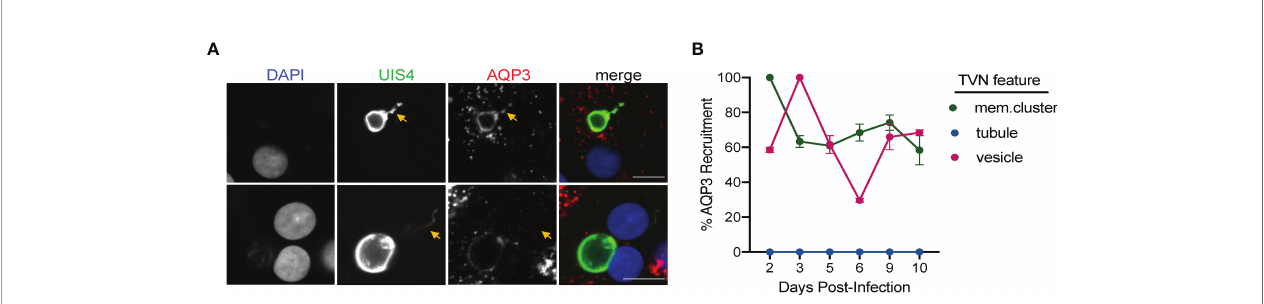
FIGURE 5 | Localization and recruitment of AQP3 to TVN features during P. vivax infection. (A) Representative confocal images of P. vivax EEFs exhibiting TVN features, stained with DAPI (blue), anti- Pv UIS4 (green), and anti- Hs AQP3 (red) at 8 dpi. P. vivax -infected PHH show localization (top) and no localization (bottom) of AQP3 to speci fi c TVN features (yellow arrows). Scale bar is 10 µm. (B) Relative percentage of TVN features in P. vivax -infected PHH exhibiting AQP3 recruitment. Data reported as mean ± SEM (2 – 10 dpi, >30 EEFs per dpi, n=2